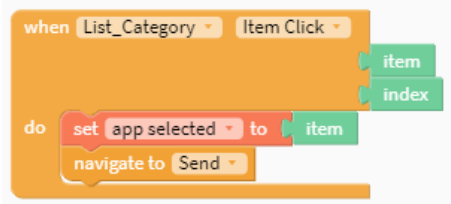
Figure 4. Drag and drop blocks in Thunkable.